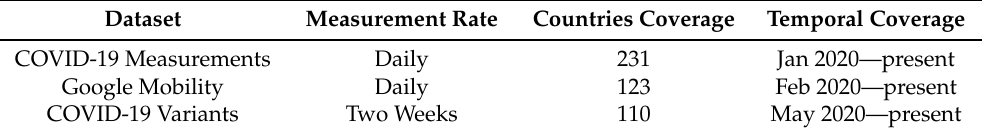
Table 1. Datasets